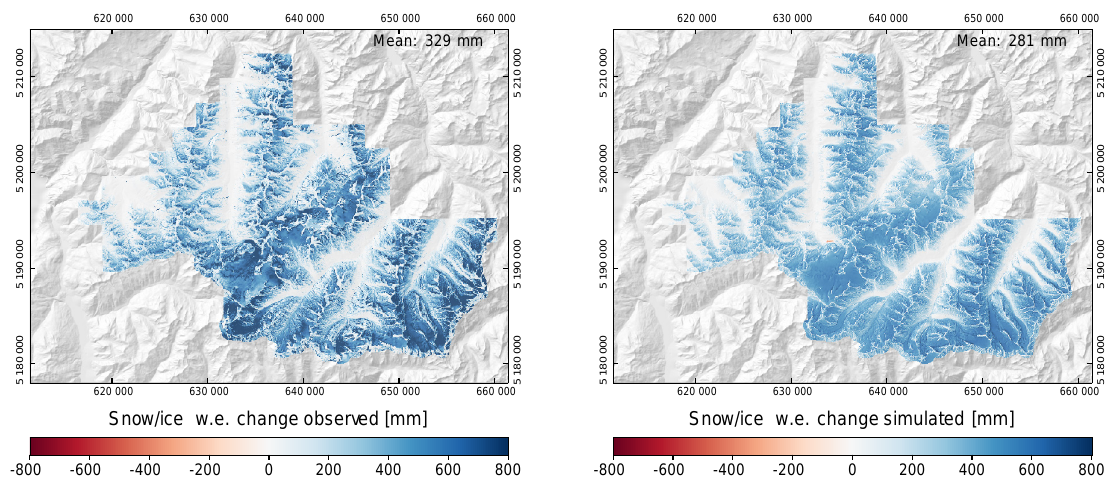
Figure 10. Observed (i.e., surface elevation differences converted to SWE using Eq. (18)) and simulated end-of-season snow distribution for the winter 2010/2011 (8 October to 22 April).